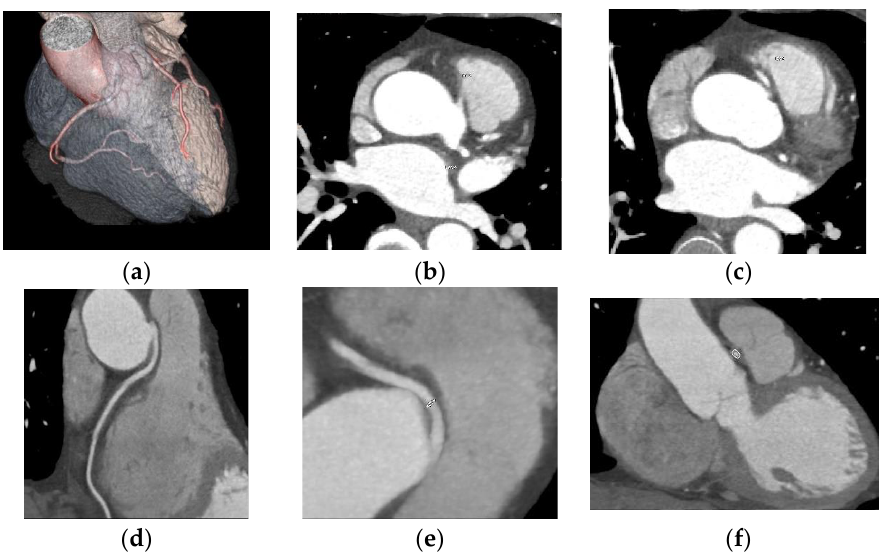
Figure 2. Anomaly of the origin of the right coronary from the left anterior coronary sinus, with a course between the pulmonary artery and the aorta. ( a ) CCTA volume rendered cardiac transparency images showing anomaly of origin and course; the right coronary anomaly originates from the left coronary sinus with an anomalous course between the left pulmonary artery and the aorta. Normal origin of the left main coronary artery from the posterior portion of the left coronary sinus with a normal trajectory. Intermediate filiform branch is present; ( b ) CCTA axial contrast-enhanced image at the aortic root showing anomaly of the origin and course; the right coronary abnormally originates from the left coronary sinus; ( c ) CCTA axial contrast-enhanced image at the aortic root showing RCA with an anomalous course between the pulmonary artery and the aorta; ( d ) CCTA curved planar reformatted image of the RCA; (e) CCTA curved planar reformatted image of the RCA origin; ( f ) CCTA vessel cross-section image of the RCA with an anomalous course between the pulmonary artery and the aorta.